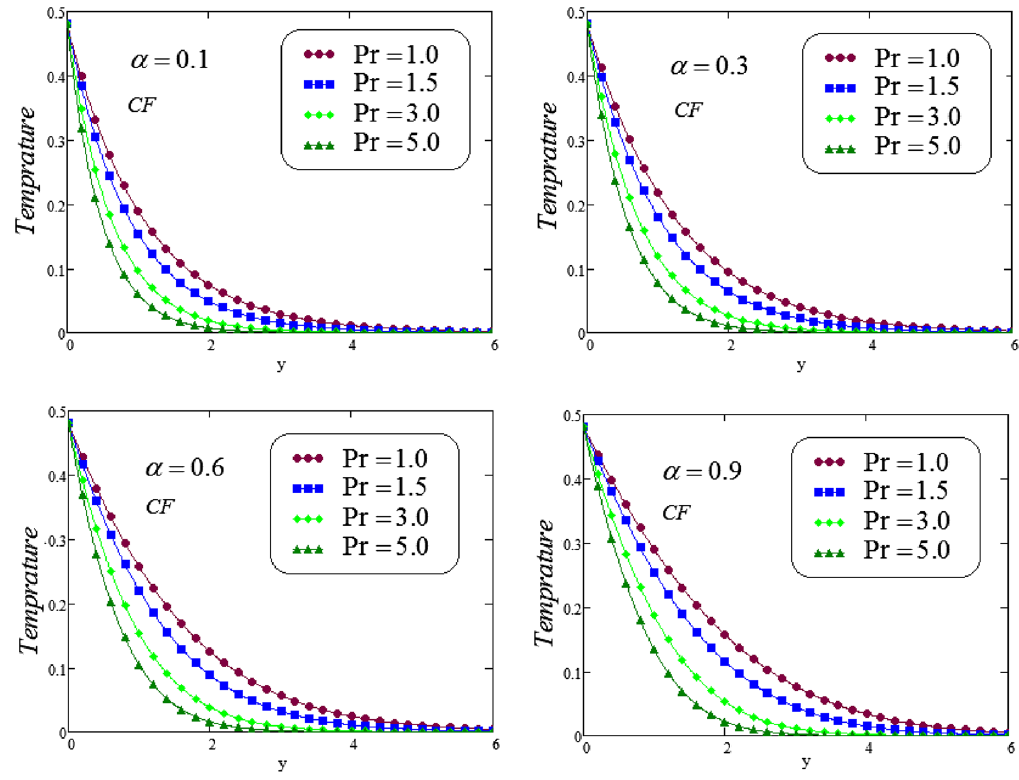
Figure 2. Simulation to illustrate the temperature profile for varying the values of Pr via CF at distinct values of the fractional parameter α